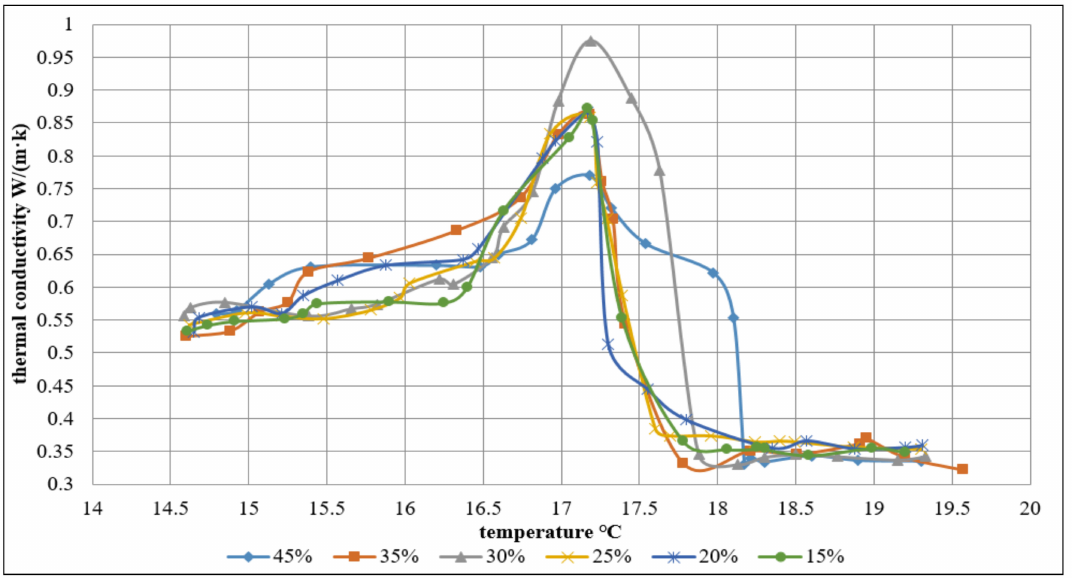
Figure 8. The variety concentration MEPCMs thermal conductivity with different